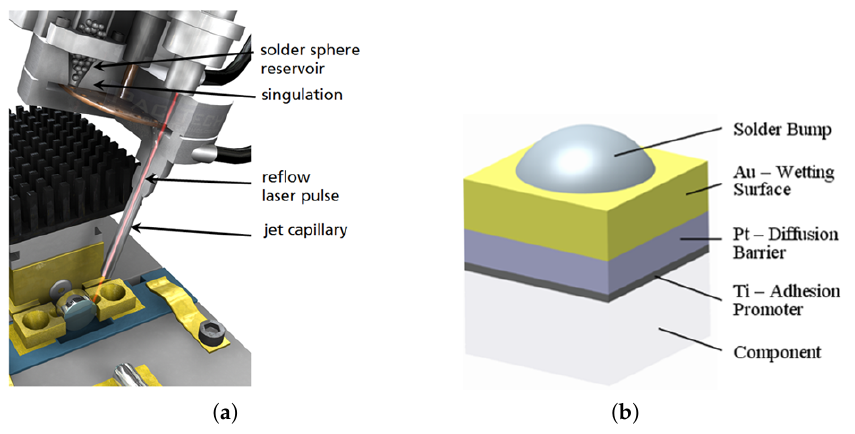
Figure 2. ( a ) Schematic of Solderjet Bumping process [20]. ( b ) Schematic of the three PVD layer system deposited on the optical components with the Solderjet bump bonded on the Au layer (not to scale)